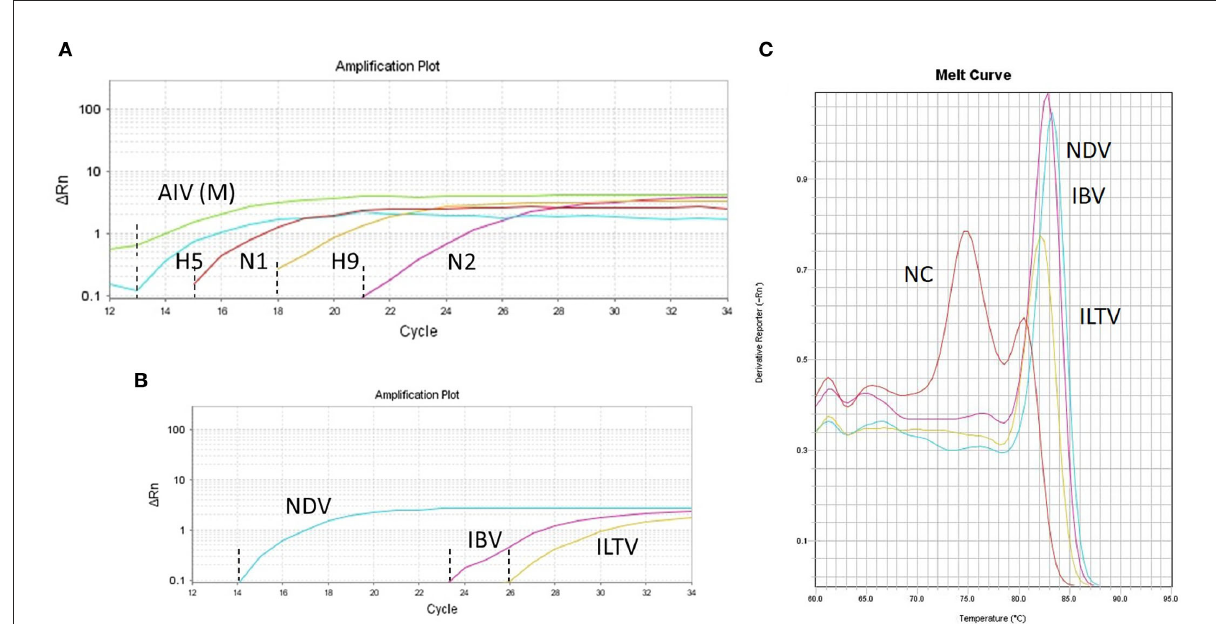
FIGURE1 RT-qPCRs amplification plots for specific target viral pathogens. (A) Simultaneous detection of generic avian influenza virus (AIV-M) and subtyping of AIV (H5, H9, N1, and N2) in a single run. (B) Simultaneous detection of Newcastle disease virus (ND), infectious bronchitis virus (IBV), and infectious laryngotracheitis virus (ILT) along with the melt curve (C) in a single run. NC denotes a negative control that shows a melt curve at a different temperature ( ∼ 75 ◦ C). The Ct values of individual gene is indicated by dash lines (A,B) generated from the number of cycles.